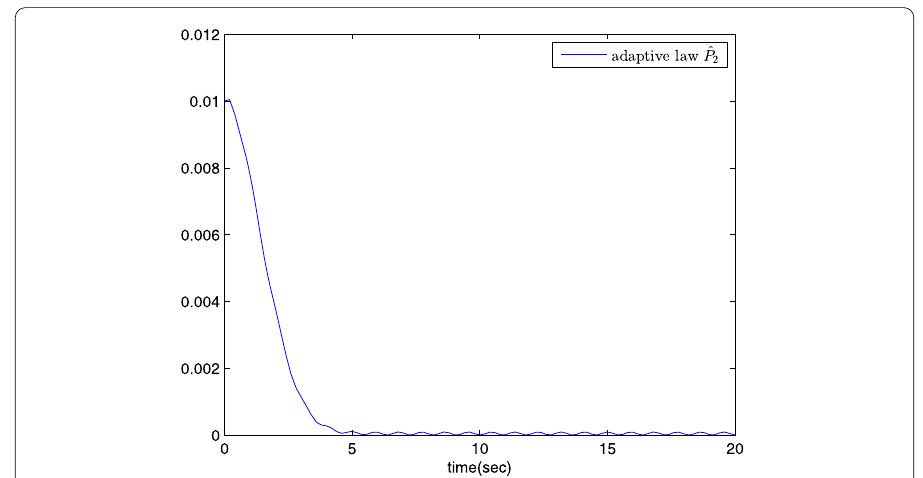
Further, z 1 = x 1 , z 2 = [ x 1 , x 2 ] T are input vectors of RBF NNs. The centers j 1 , j 2 are spaced on [–2,2] simultaneously, the widths are defined as (cid:10) 1 = (cid:10) 2 = 2, the initial values of the system states are x 1 (0) = 0.01, x 2 (0) = 0.2, respectively, and ˆ u ˆ u 1 (0) = 2 (0) = 0.04 denote the initial values of the actuator fault. By the above analysis, Fig. 1 expresses the arbitrarily chosen switching signal. From Fig. 2, a good tracking performance is obtained. The subsystem controllers u 1 , u 2 are given in Figs. 3 and 5. Figures 4 and 6 correspond to the adaptive law. From the above figures, it is shown that all the signals in the closed-loop system are bounded. Then, in order to illustrate the effectiveness of our method, with the other parameters unchanged, we verify whether the system has good tracking performance when the reference signal is selected as y d = 0.1( sin (1.5 t ) + sin ( t )). From Fig. 7, one can see the tracking performance is nice. Thus our method is